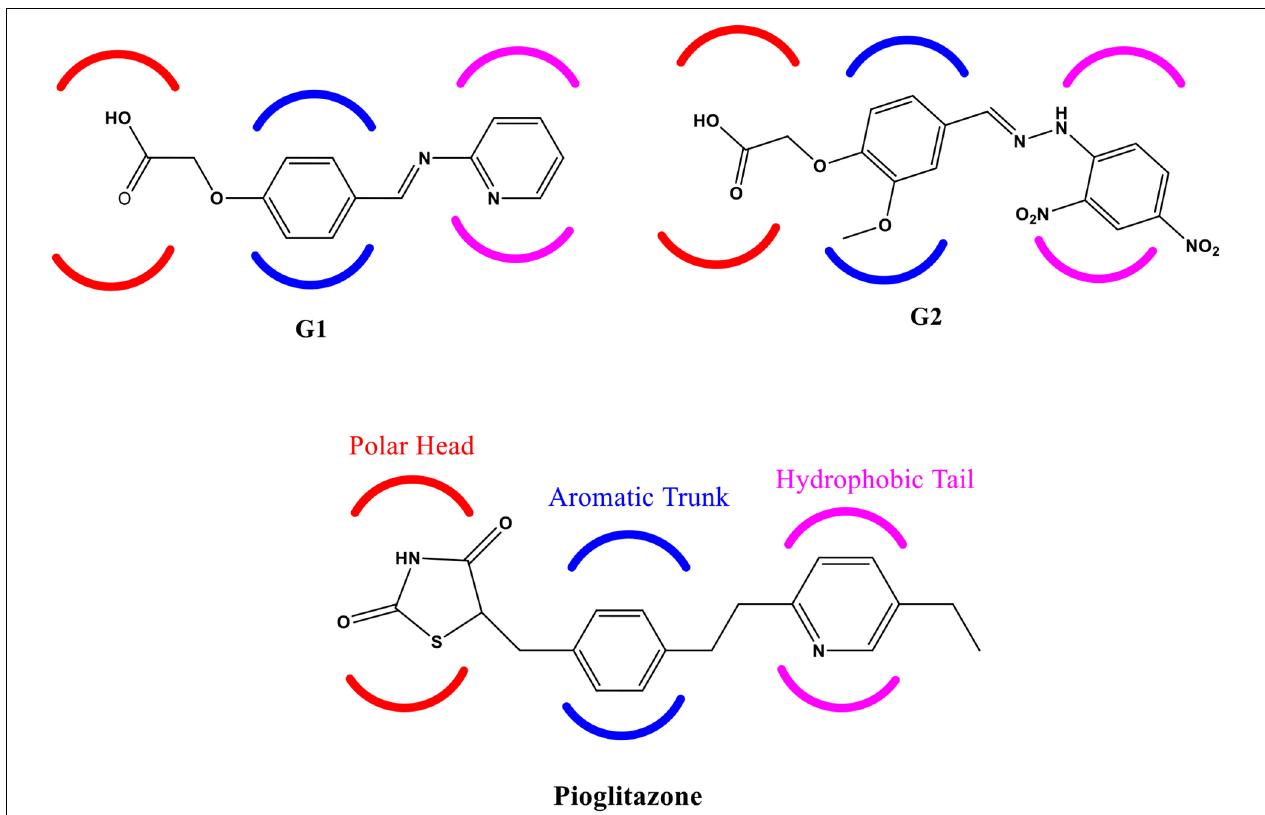
FIGURE 1 | Structure of Glitazone 1 (G1), Glitazone 2 (G2), and standard pioglitazone with conserved regions for binding to PPAR- γ receptor